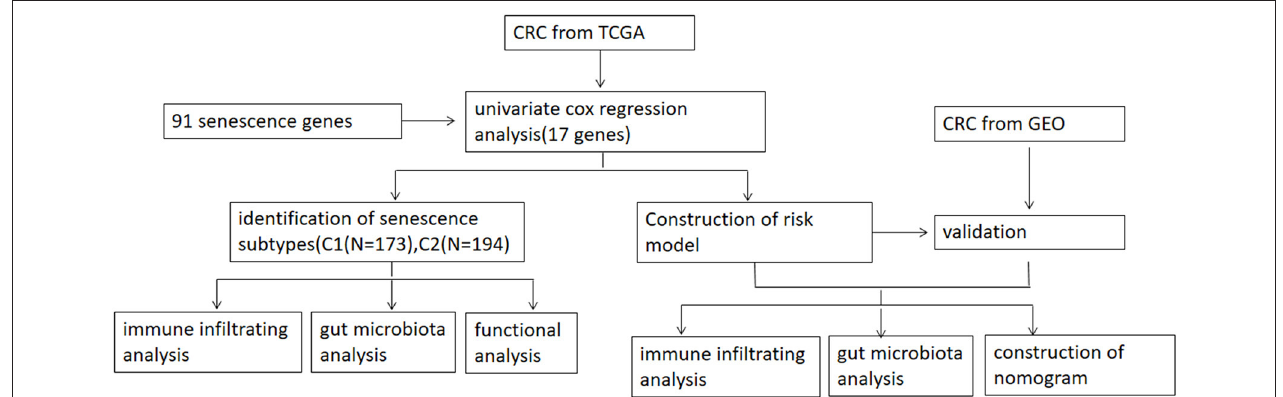
FIGURE 1 | Workflow of the analytic